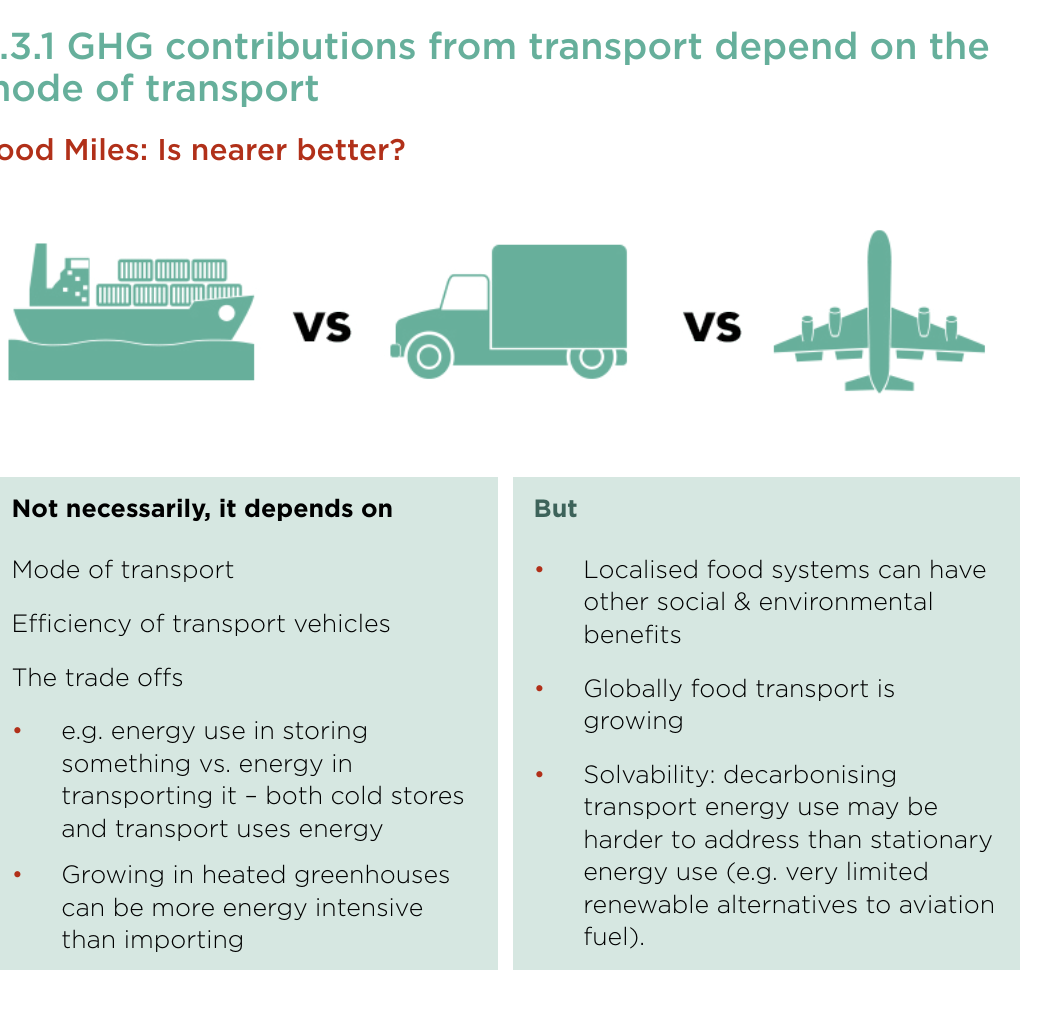
Figure 13: Food miles – is nearer better? Source: FCRN.